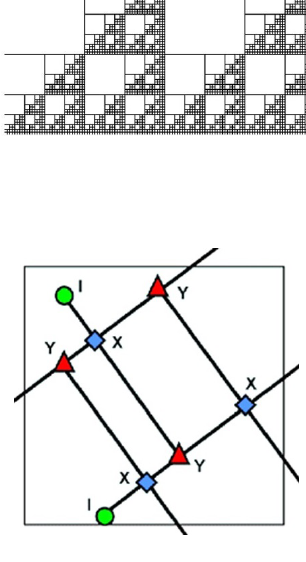
Figure 4. I (isolated), X (intersection) and Y (abutments) nodes in a fracture network (Sanderson and Nixon,